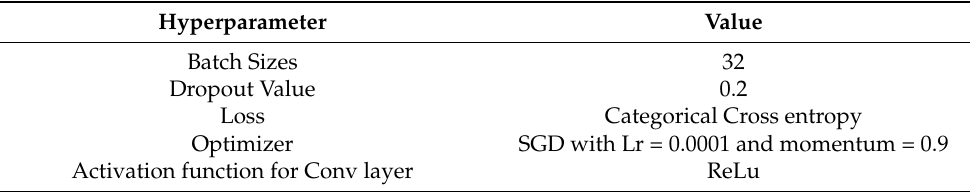
SGD with Lr = 0.0001 and momentum = 0.9 Activation function for Conv layer